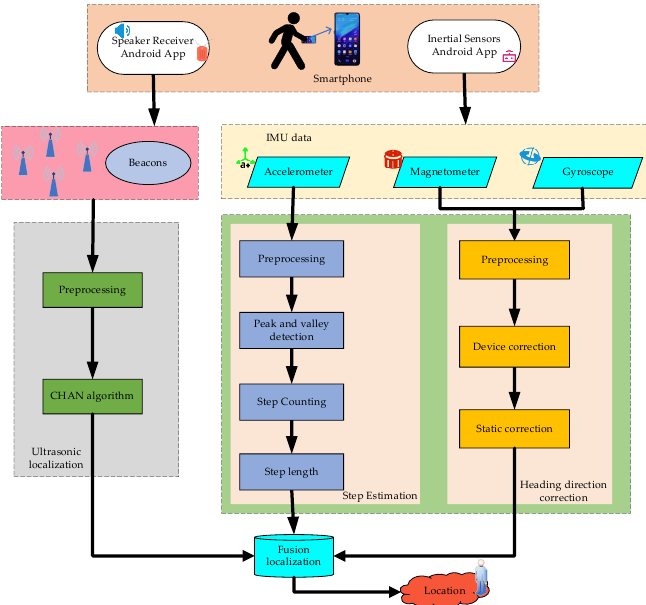
Figure 1. Localization system scheme combining ultrasonic signals and inertial signals.